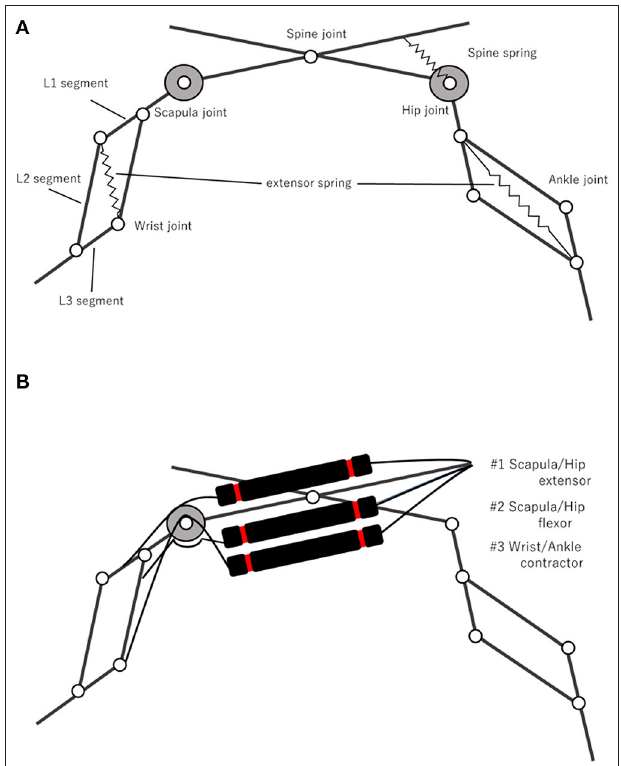
FIGURE 2 | Musculoskeletal structure of “PneuHound.” Each leg, consisting of four links and four joints, one of which is constrained by a pantograph mechanism, has two DOFs. Passive springs are provided on the spine joint and pantograph mechanisms (A) . There are three muscles for each limb; #1 Scapula/Hip extensor, #2 Scapula/Hip flexor, and #3 Wrist/Ankle contractor, and each pantogragh leg is composed of an L 1segment, L 2segment, and L 3segment (B) .